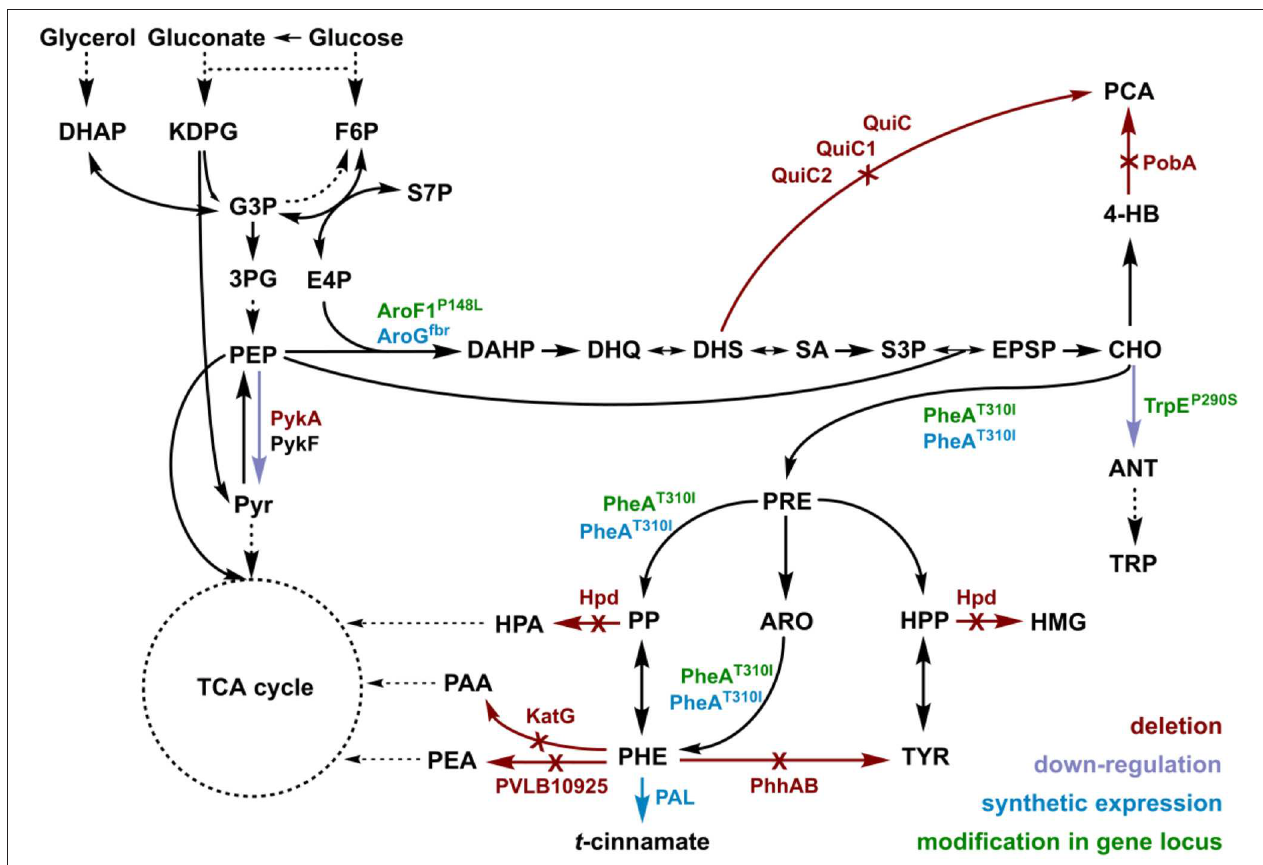
FIGURE 2 | Genomic modifications introduced into strain P. taiwanensis GRC3 to enable accumulation of L -phenylalanine and subsequent deamination to t -cinnamate. Red arrows and annotations indicate gene deletions, purple arrows represent enzymatic downregulation, green annotations highlight point mutations introduced into the native gene locus, and blue tags and arrows represent the overexpression of heterologous genes. DAHP, dihydroxyacetone phosphate; KDPG, 2-keto-3-deoxy-6-phosphogluconate; F6P, fructose-6-phosphate; G3P, glyceraldehyde-3-phosphate; 3PG, 3-phosphoglycerat; S7P, seduheptulose-7-phosphate; PEP, phosphoenolpyruvate; PYR, pyruvate; E4P, erythrose-4-phosphate; DAHP, 3-deoxy- D -arabinoheptulosonate-7-phosphate; DHQ, 3-dehydroquinate; DHS, 3-dehydroshikimate; SA, shikimate; S3P, shikimate-3-phosphate; EPSP, 5-enolpyruvyl-shikimate-5-phosphate; CHO, chorismate; 4-HB, 4-hydroxybenzoate;